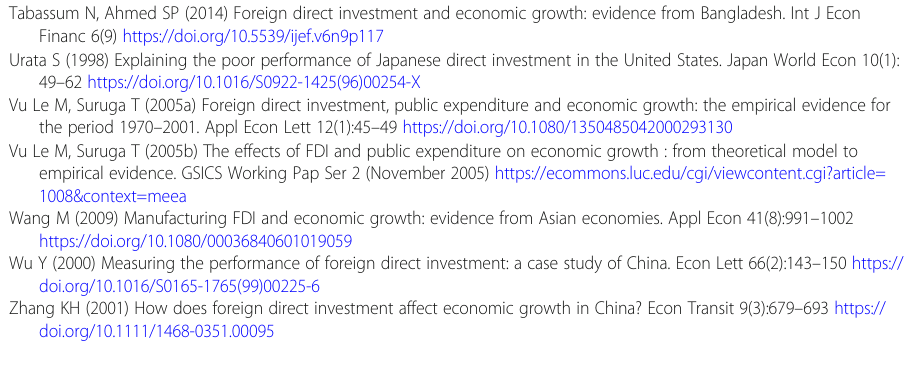
Tabassum N, Ahmed SP (2014) Foreign direct investment and economic growth: evidence from Bangladesh. Int J Econ Financ 6(9) https://doi.org/10.5539/ijef.v6n9p117 Urata S (1998) Explaining the poor performance of Japanese direct investment in the United States. Japan World Econ 10(1): 49 – 62 https://doi.org/10.1016/S0922-1425(96)00254-X Vu Le M, Suruga T (2005a) Foreign direct investment, public expenditure and economic growth: the empirical evidence for the period 1970 – 2001. Appl Econ Lett 12(1):45 – 49 https://doi.org/10.1080/1350485042000293130 Vu Le M, Suruga T (2005b) The effects of FDI and public expenditure on economic growth : from theoretical model to empirical evidence. GSICS Working Pap Ser 2 (November 2005) https://ecommons.luc.edu/cgi/viewcontent.cgi?article=